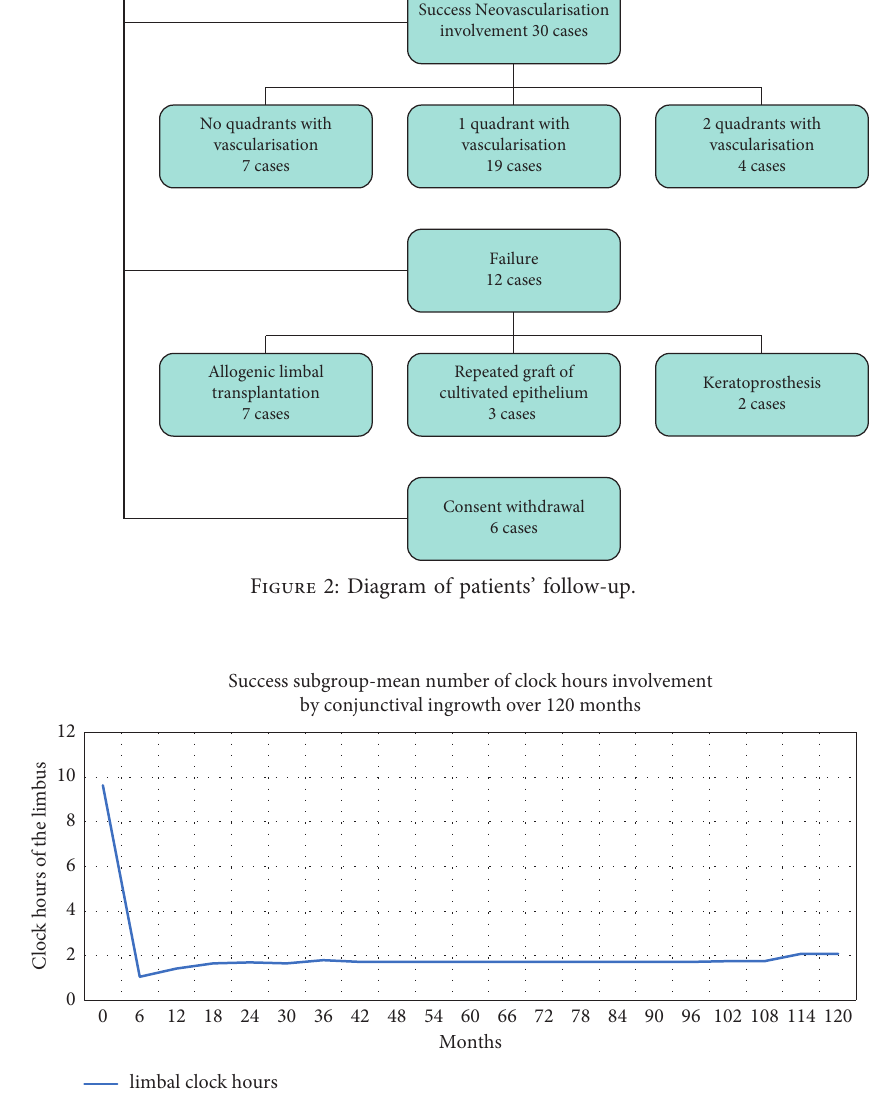
Figure 3: Average of clock hours of conjunctival invasion in success group over 120